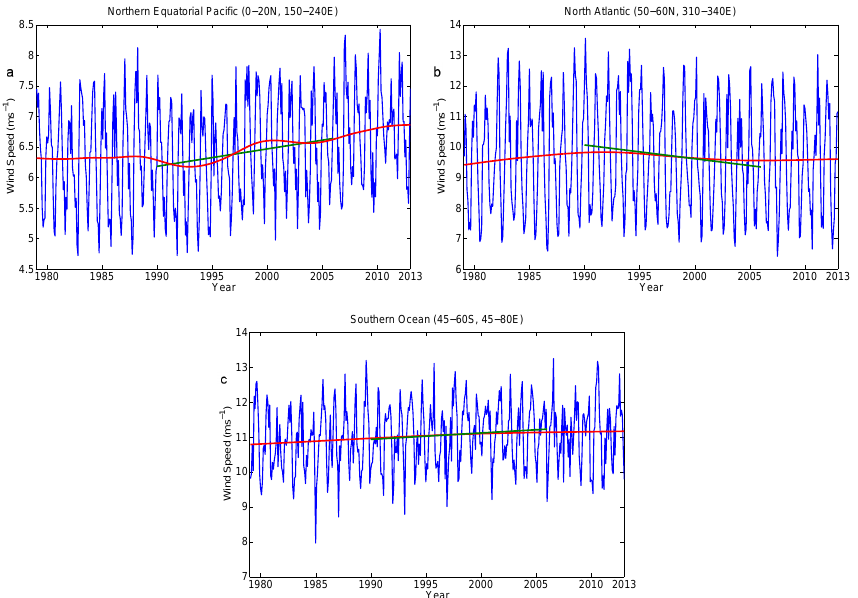
Figure 2. Comparison of monthly mean values (blue line), linear trend (1990–2004, green line), and locally linear mean level (1979–2012, red line) of ERA-Interim 10m wind speed in (a) the Northern Equatorial Pacific, (b) the North Atlantic, and (c) the Southern Ocean. These regions are marked with black boxes in Fig.